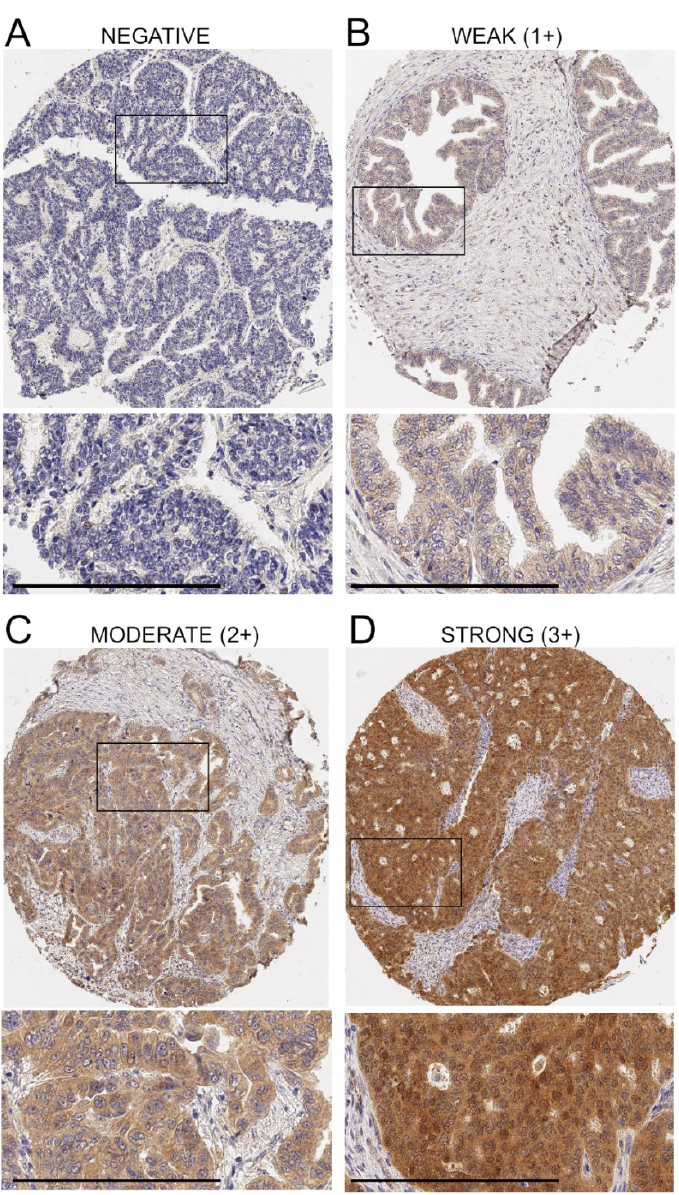
Figure 1. Variation of ADAM17 protein expression in ovarian cancer tissue. Representative examples of ADAM17-negative tissue ( A ) and weak ( B ), intermediate ( C ) and strong ( D ) immunostaining are shown. Bar = 200 µ m. Enlarged areas are marked by insets. Once the staining intensity was integrated with the percent of positive cells, the final H score values generated for these cores were equal to 0 ( A ), 100 ( B ), 200 ( C ) and 240 ( D